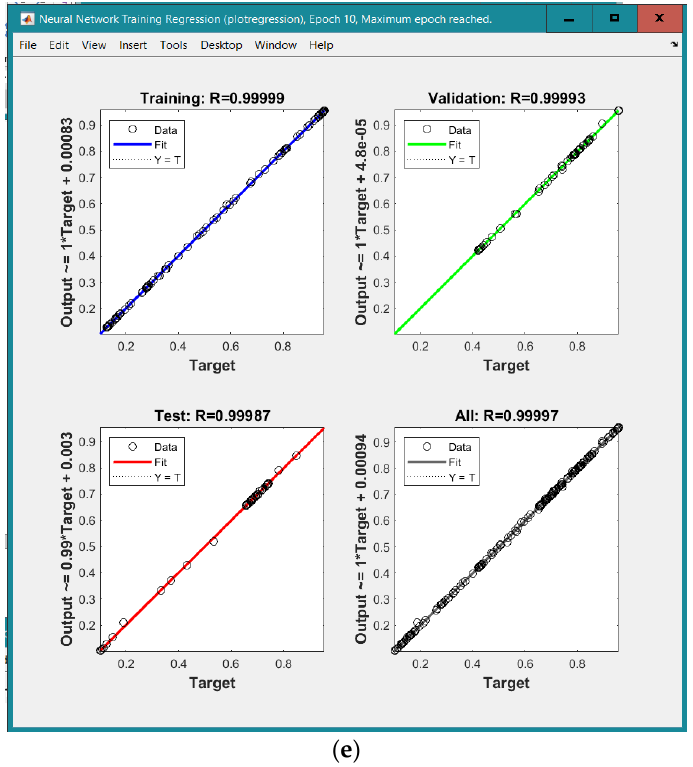
Figure 6. NNEV identification: ( a ) conditions; ( b ) training data; ( c ) training result; ( d ) performance; ( e ) regression.